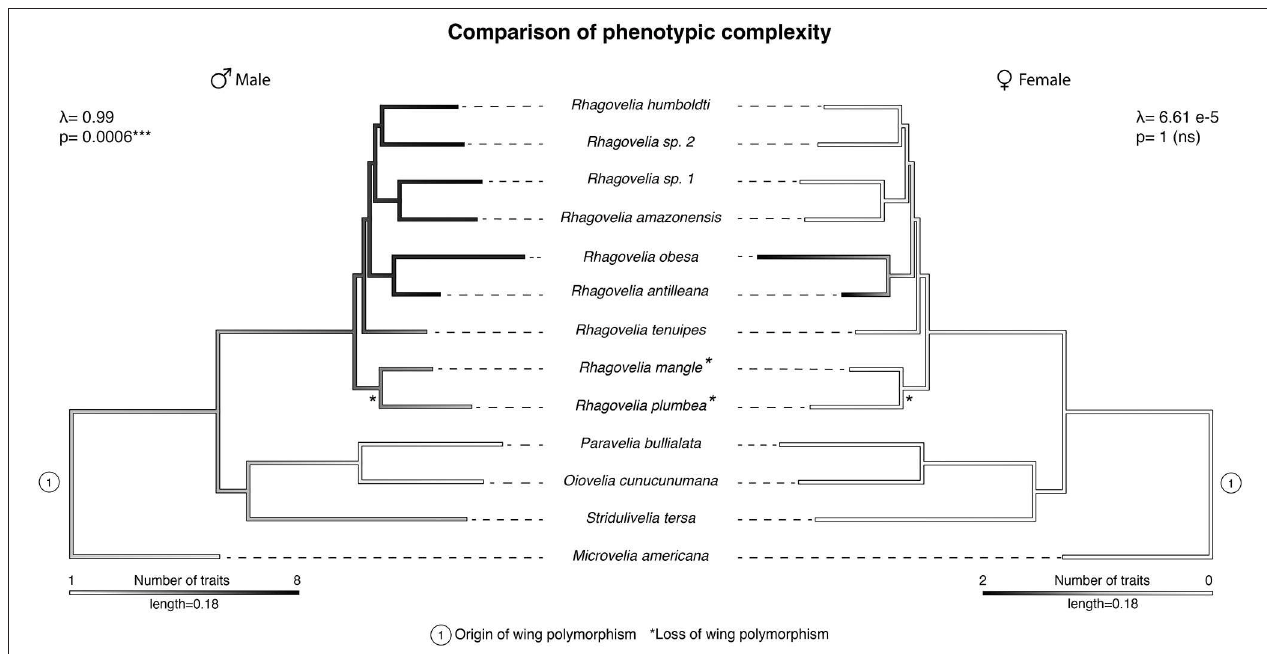
FIGURE 4 | Comparison of male and female phenotypic complexity. The phylogeny of our samples shows a higher complexity of male phenotypes, in terms of number of secondary sexual traits, compared to outgroups (left phylogeny). This complexity is associated with strong phylogenetic signals in males. Male complexity is followed by higher complexity in females in two species R. antilleana and R. obesa (right phylogeny), the ones that possess narrow abdomen and pronotum projection, suggesting an ongoing arms